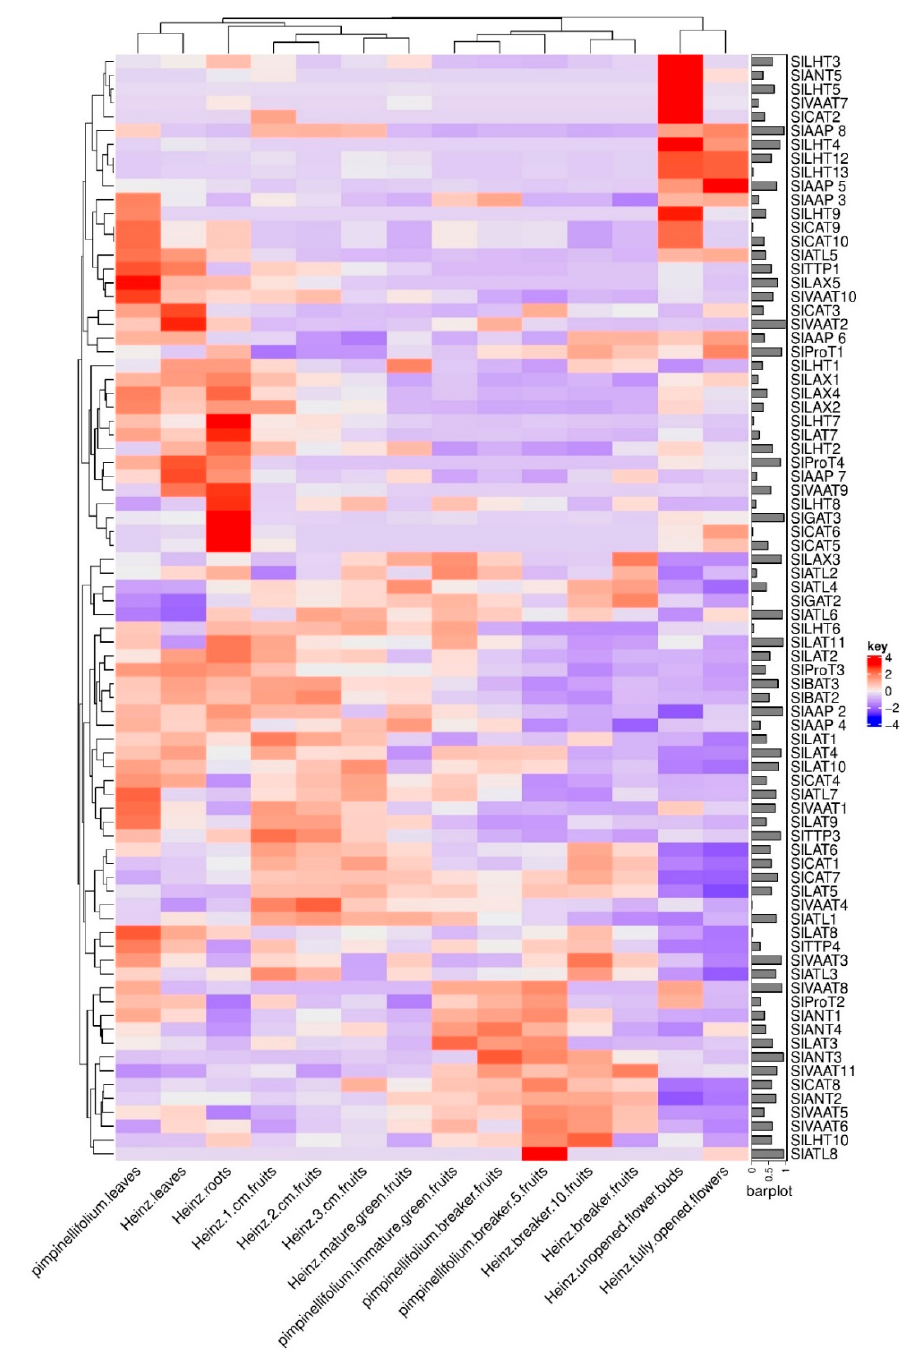
Figure 6. Expression patterns of genes in various tissues of Solanum lycopersicon ‘Heinz and their orthologues/paralogs in the wild relative S. pimpinellifolium , which were retrieved by the Locus identity number of SlAATs included in Table 1. The data for RNA sequencing were obtained from a public database (the Tomato Functional Genomics Database), and were analyzed and generated using ComplexHeatmap version 2.2.0 package in R.